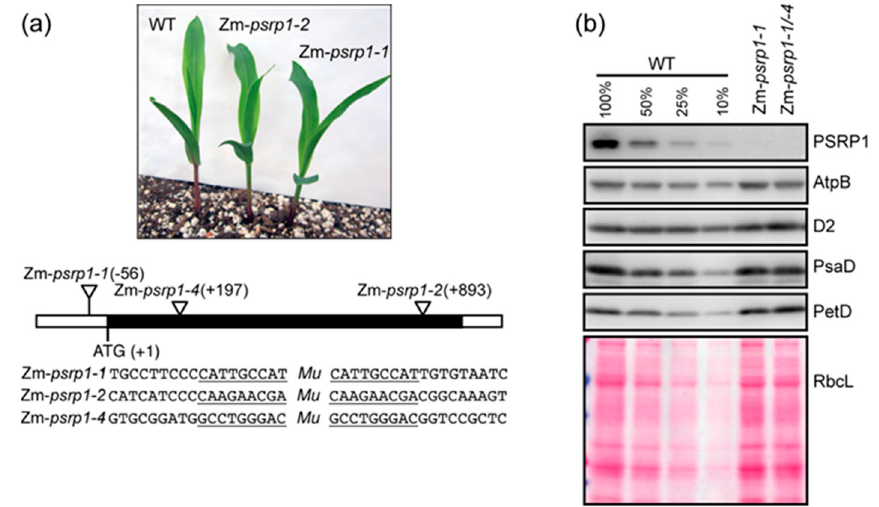
Figure 3. Maize psrp1 mutants. ( a ) Mutant and wild-type (WT) (inbred line B73) seedlings at the developmental stage used for experiments reported here. The positions of the Mu insertions in each allele are shown below, with the target site duplications underlined. The black rectangle indicates the single exon in the gene. Additional images of mutant seedlings are shown in Figure S1. ( b ) Immunoblots showing the abundance of PSRP1 and representative subunits of photosynthetic complexes in Zm- psrp1 mutants. Replicate blots were probed to detect AtpB, D2, PsaD, and PetD (subunits of the ATP synthase, Photosystem II, Photosystem I, and the cytochrome b 6 f complex, respectively). An image of one of the blots stained with Ponceau S is shown below to illustrate equal sample loading and the abundance of the large subunit of Rubisco (RbcL). An immunoblot demonstrating the absence of PSRP1 in Zm- psrp1-2 homozygotes is shown in Figure 4a.